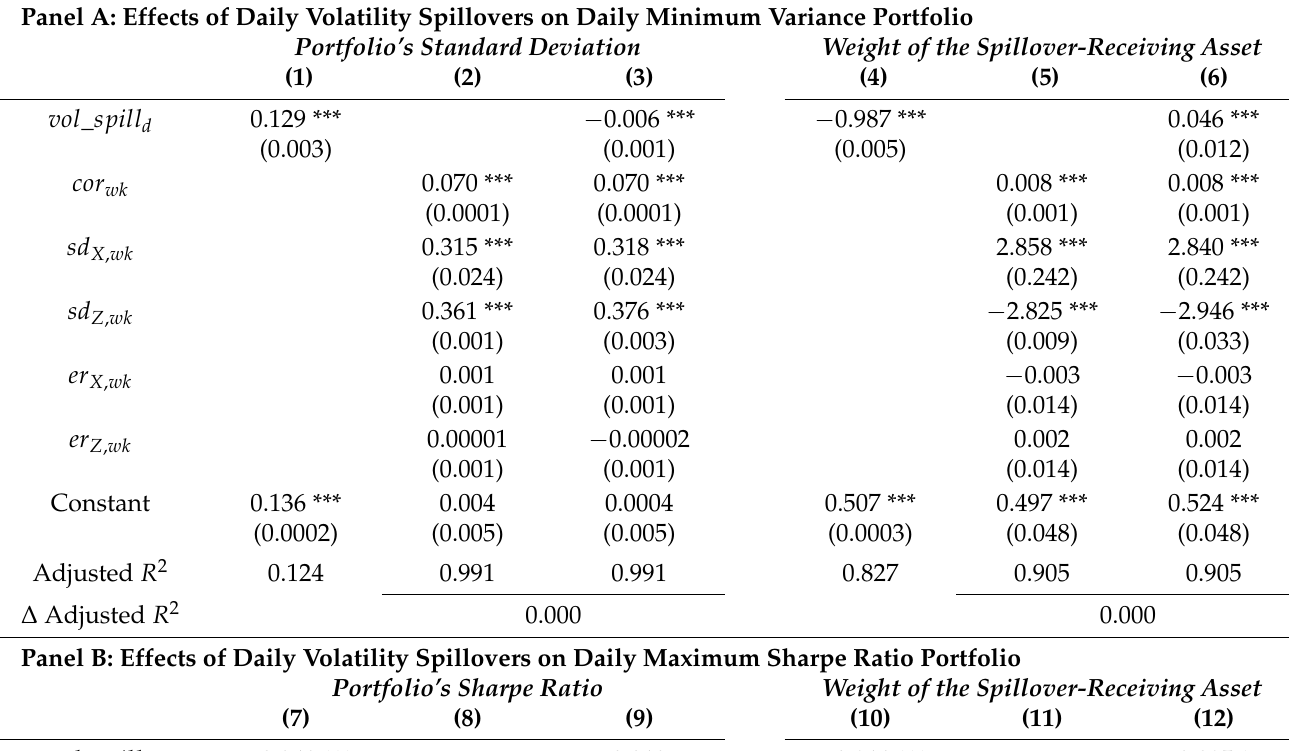
Table 4. Effects of volatility spillovers on optimal portfolios. This table presents the results from the regression on daily volatility spillovers ( vol _ spill d ) with dependent variables are either the standard deviation of the portfolio targeting minimum variance, the Sharpe ratio of the portfolio targeting maximum Sharpe ratio, or the corresponding weight of the spillover-receiving asset in such optimum portfolios. Portfolios are formed by either daily or weekly returns. We use “daily” and “weekly” for the illustration purpose; the results also apply to other relative “high” and “low” frequencies. The last row in each Panel presents the difference between Adjusted R 2 of the full model and the restricted model without spillover. Standard errors are in parentheses. *, **, and *** denote significance levels of 10%, 5%, and 1%,